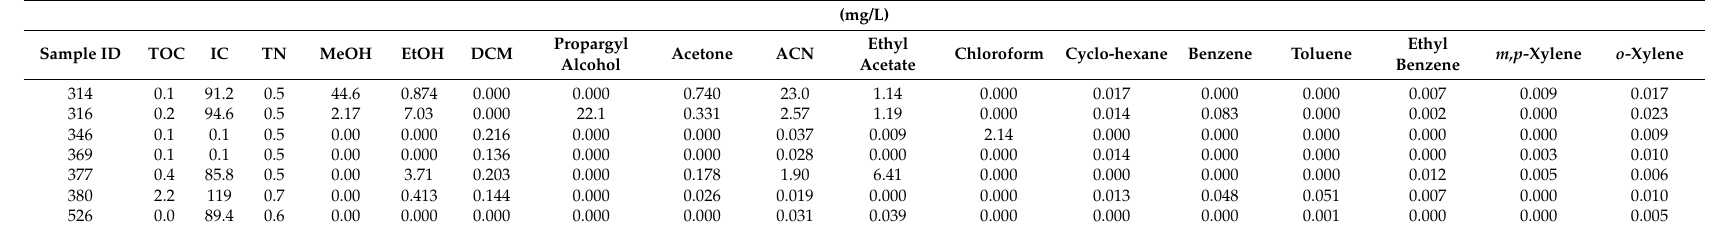
Table 2. Concentrations (mg/L) of constituents in groundwater samples